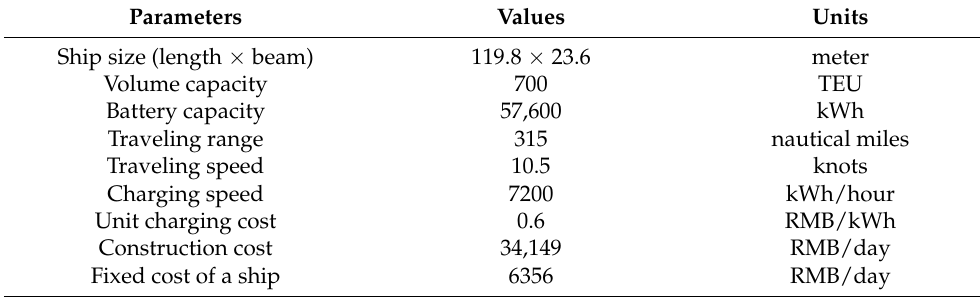
Table 4. Parameter values.